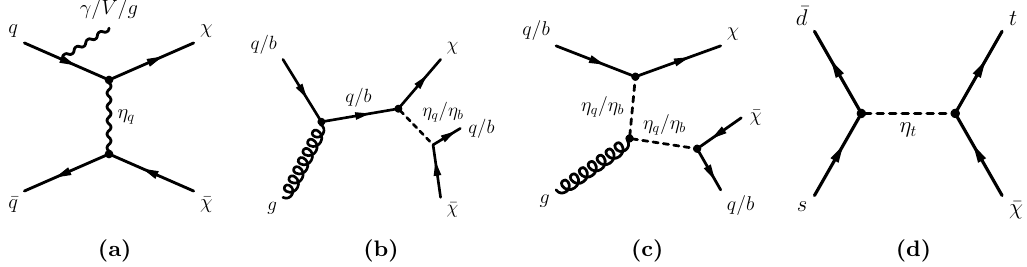
Figure 4. Schematic representation of the dominant production and decay modes for the SCC